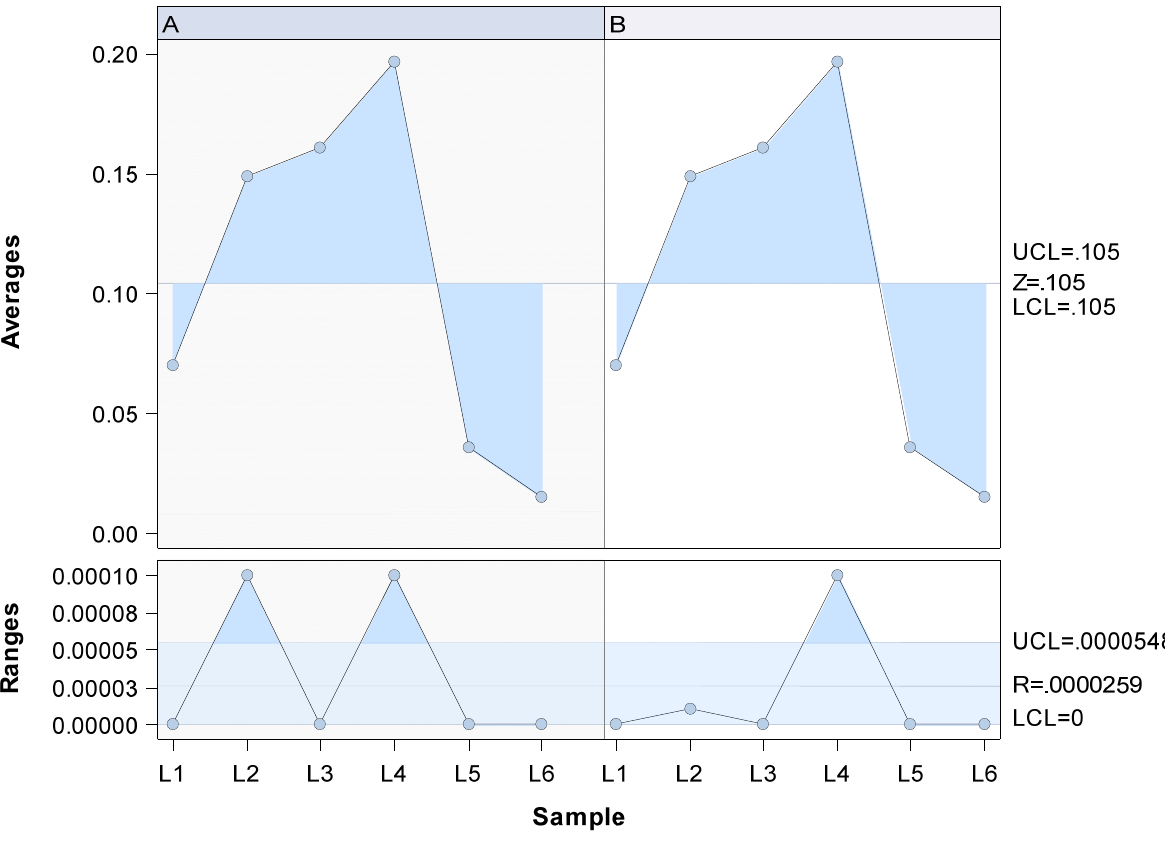
Figure 5. Mean values of the six measurements of the volume wear of CM-wire NiTi alloy endodontic reciprocating files after use, performed by operators A and B (average), and the differences between the six measurements of the volume wear of CM-wire NiTi alloy endodontic reciprocating files after use (range).